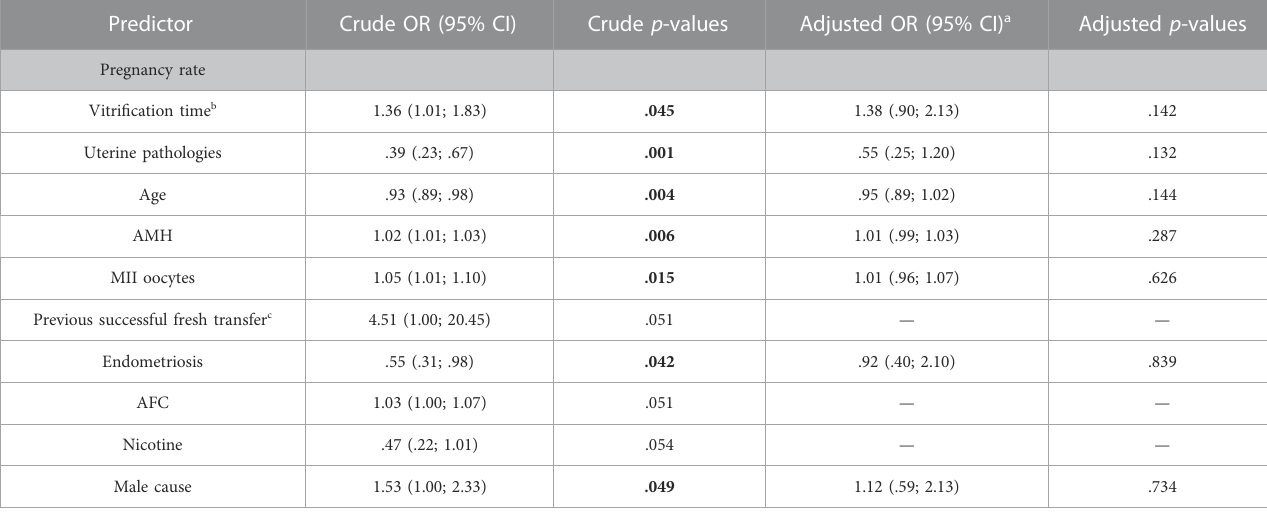
TABLE 6 Uni- and multivariate analysis with vitri fi cation time as continuous variable. Predictor Crude OR (95% CI) Crude p -values Pregnancy rate